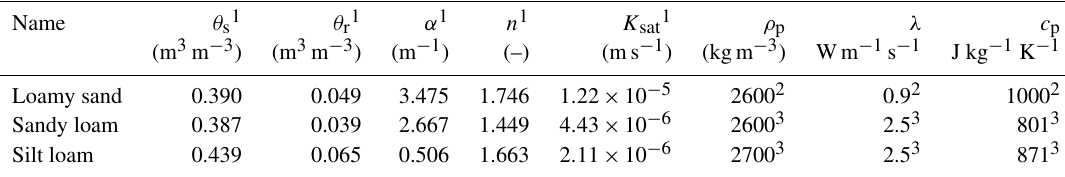
Table 4. List of parameters for the soil types for saturated water content ( θ s ), residual water content ( θ r ), the van Genuchten parameters α and n , the saturated hydraulic conductivity ( K sat ( 1 ) ), the density of soil particles ( ρ p ), the thermal conductivity of soil particles ( λ ) and the specific heat of soil particles ( c p